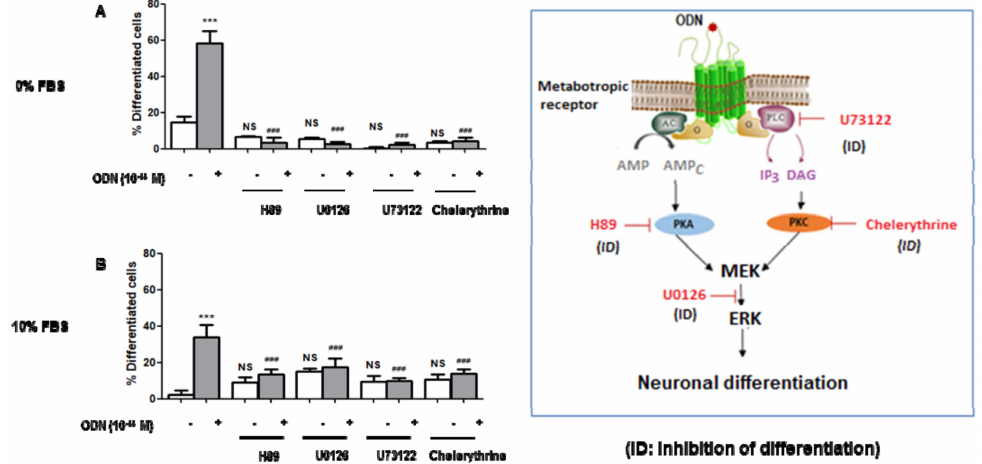
Figure 6. Signaling pathways triggered by ODN during neuronal di ff erentiation of N2a cells. Murine neuronal N2a cells previously cultured for 24 h in conventional medium were further cultured for 48 h in medium without ( A ) or with 10% FBS ( B ) in the absence or in the presence of (ODN: 10 − 14 M) without or with di ff erent inhibitors: H89 (2 × 10 − 5 M; PKA inhibitor), U73122 (10 − 7 M; PLC inhibitor),